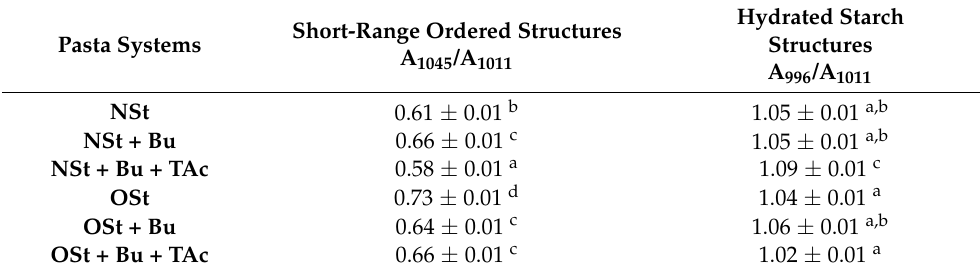
Figure 2. Panel ( A ) ATR/FTIR spectra from the different spaghetti-type pasta systems studied in the whole absorbance range. Panel ( B ) Region of normalized ATR/FTIR spectra for analysis of short-range ordered structures and hydrated starch structures. Spaghetti-type pasta systems: ( a ) NSt, ( b ) Table 1. Structural analysis from the variations of the absorbances of the ATR/FTIR spectra of the different spaghetti-type pasta systems studied.